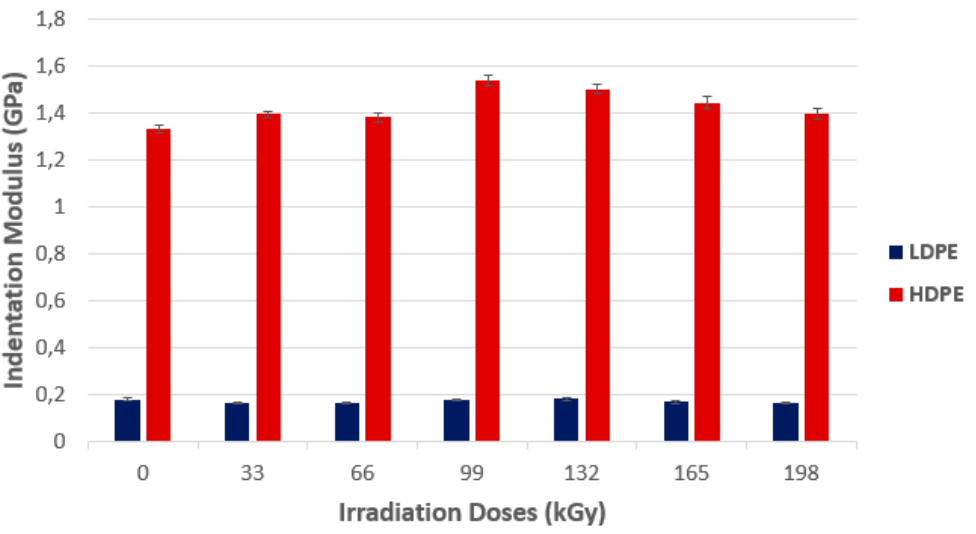
Figure 4. Indentation modulus ( E IT )—Commodity polymers.